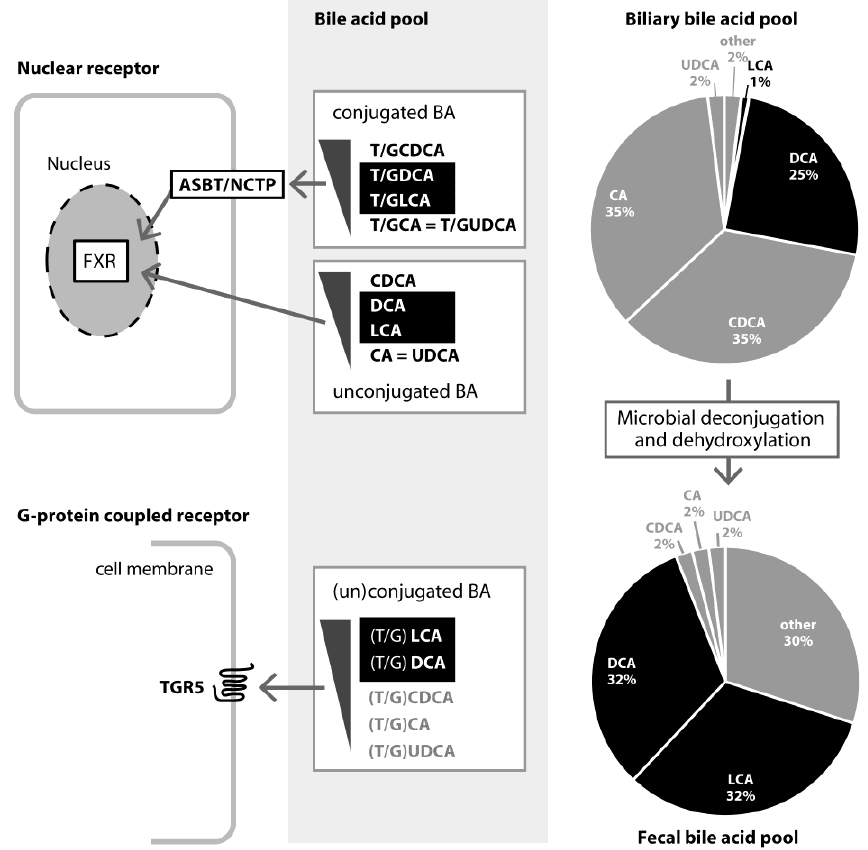
Figure 1. Composition of bile acids in the gallbladder and feces of healthy individuals and their signaling